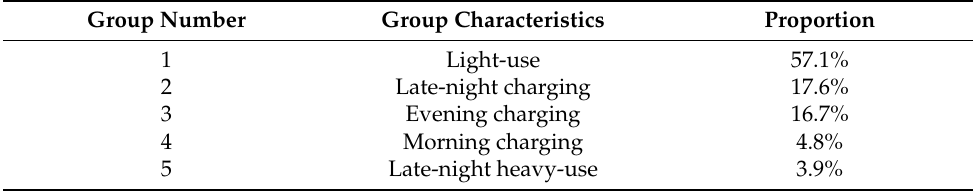
Table 1. EV user segmentation